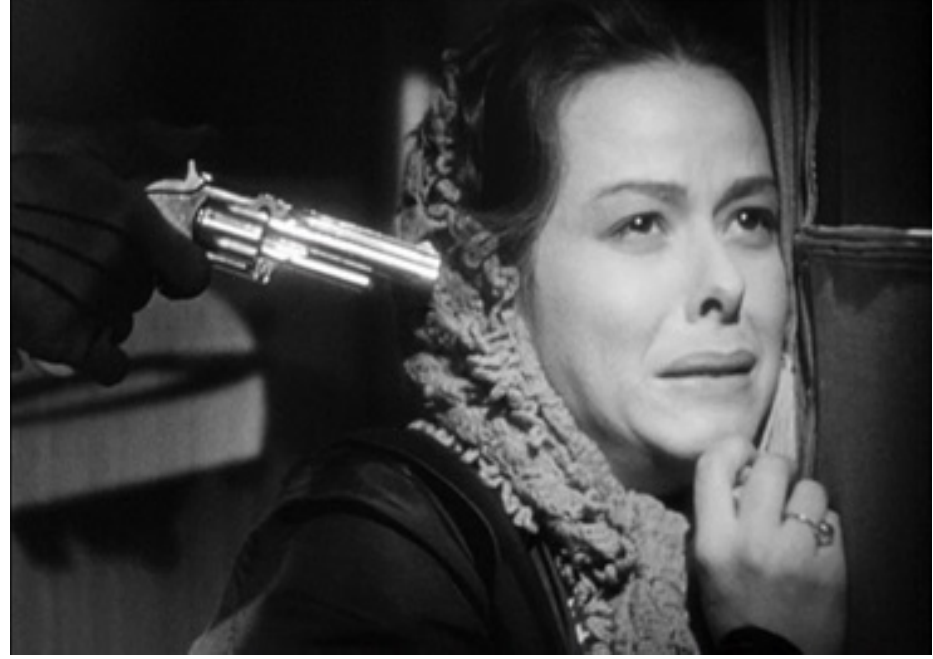
Figure 9: In the desperate moments of the attack, Hatfield saves his last bullet to shoot Lucy Mallory and spare ‘a lady’ from violation by the Apaches. Lucy prays for divine help while Dallas cares for the child. Hatfield is shot, just as the cavalry arrive to save the coach. They seemed unconcerned that Dallas might be similarly